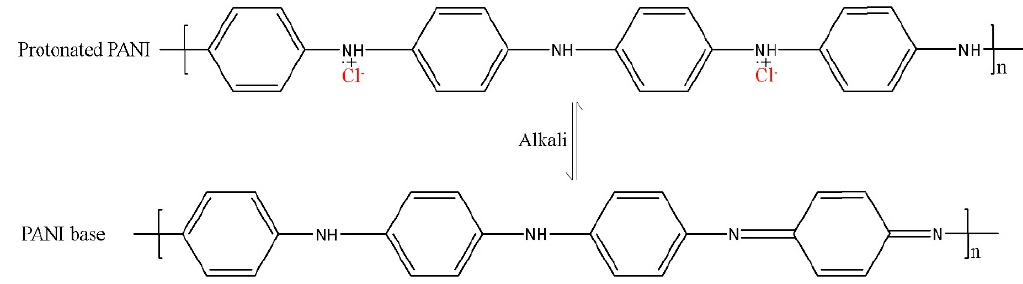
Scheme 9. Schematic diagram of the conversion process between protonated PANI (HCl as an example) and PANI base by treating with alkali.